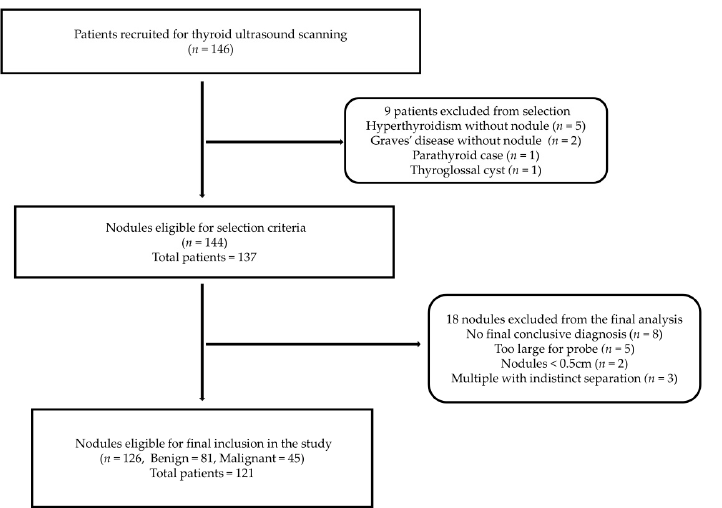
Figure 3. The image selection process of the ultrasound images of the thyroid nodules for the SWE study.